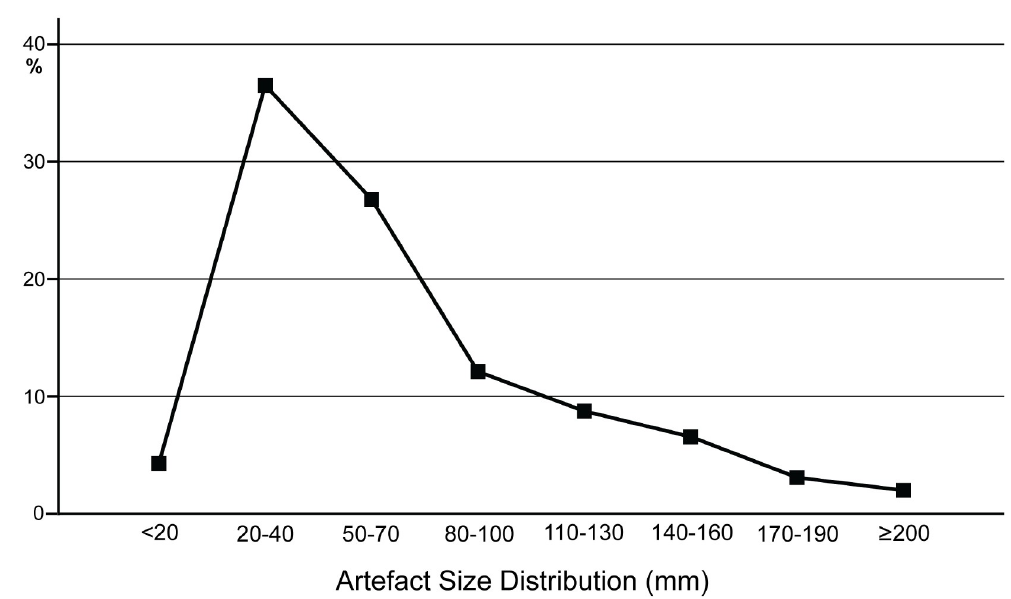
Fig 13. Artefact size curve. Artefact size curve indicating a lack of materials < 20mm.